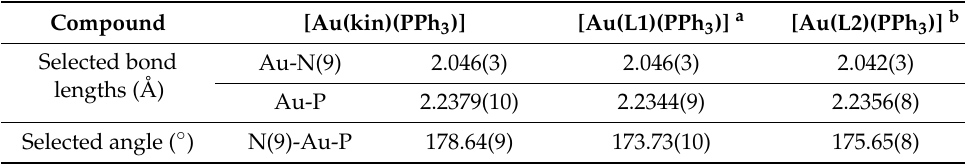
Figure 2. X-ray structure of [Au(kin)(PPh 3 )] ( 1 ). The labelling of the carbon (dark grey) and hydrogen (light grey) atoms is omitted for better clarity. The molecular graphics were generated in Diamond software (Crystal Impact, Bonn, Germany). Table 1. Selected bond lengths (Å) and angles ( ◦ ) for [Au(kin)(PPh 3 )] ( 1 ) and their comparison with similar Au(I) complexes containing O -ethyl-7-deazahypoxanthine (HL1) and O -propyl-7- deazahypoxanthine